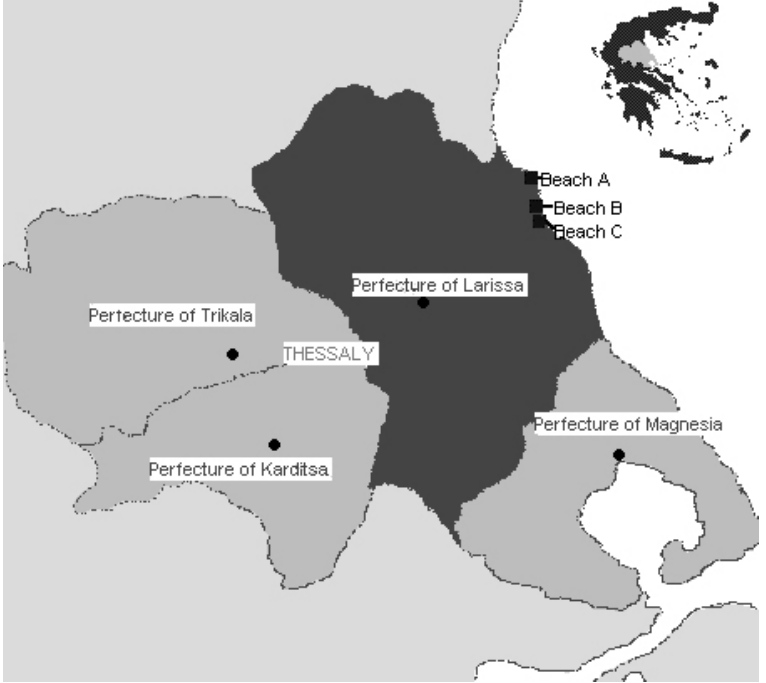
Figure 1. Marine beach